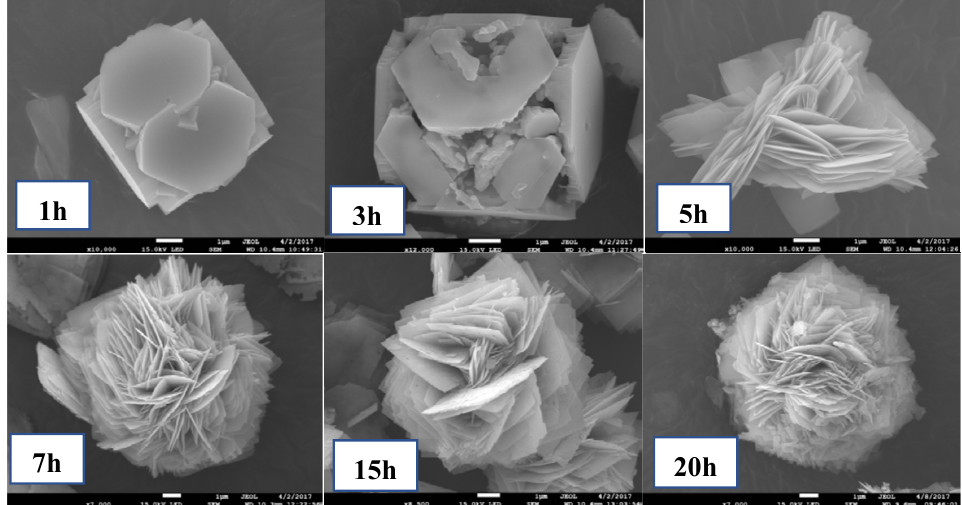
Figure 4. SEM images of products obtained in various reaction stages (1 h,3 h,5 h,7 h,15 h,20 h) [114].